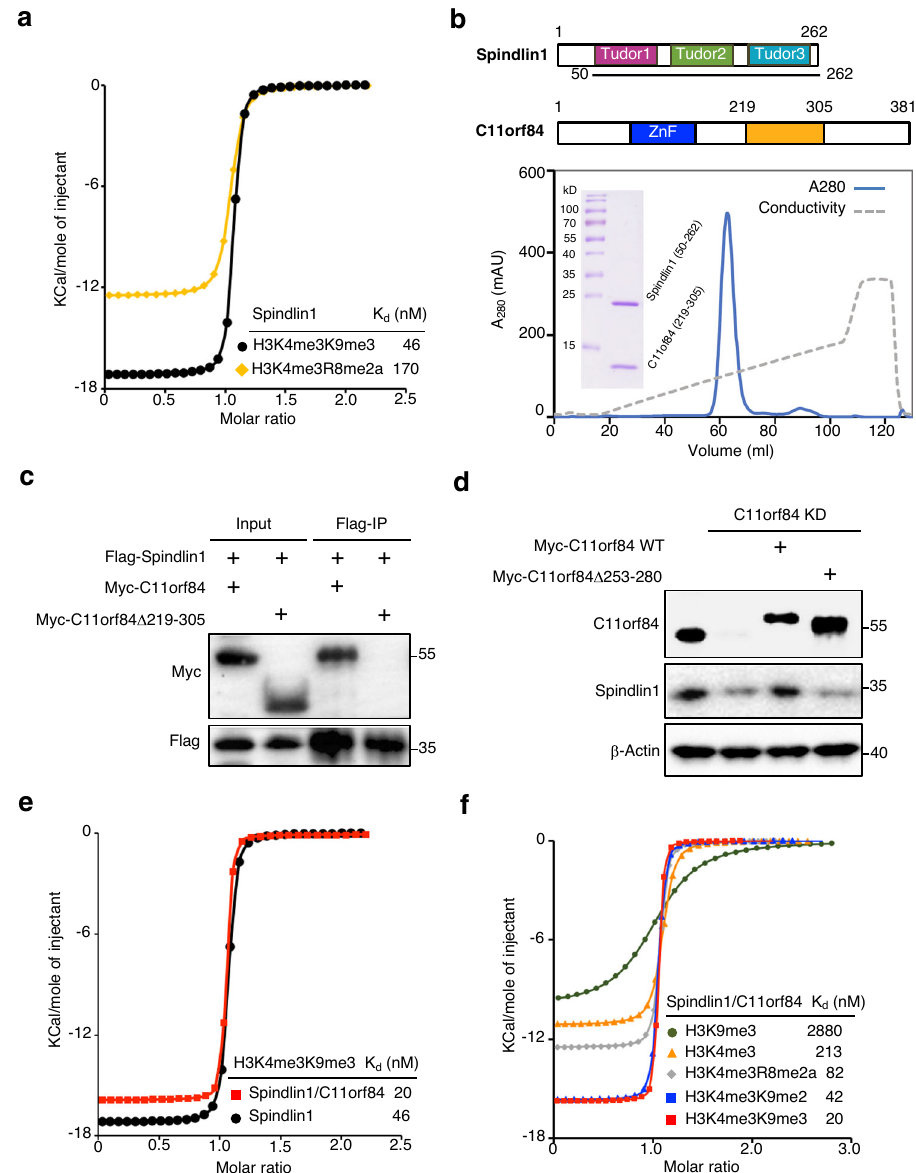
Fig. 1 Spindlin1/C11orf84 complex prefers to recognize non-canonical bivalent mark H3K4me3K9me3. a Quantitative ITC measurements suggest that Spindlin1 binds H3K4me3K9me3 dual mark with a fourfold increase in binding af fi nity over H3K4me3R8me2a. The insert lists the calculated dissociation constant ( K d ). b The top panel shows protein architecture of Spindlin1 and C11orf84. The lower panel shows that Spindlin1 (aa: 50 – 262) forms a stable complex with C11orf84 (aa: 219 – 305) as analyzed by anion-exchange chromatography and SDS-PAGE gel of the peak fraction. c Coimmunoprecipitation (Co-IP) shows the region (aa: 219 – 305) of C11orf84 is responsible for Spindlin1 binding. d Immunoblotting shows the Spindlin1 protein level is dramatically reduced in C11orf84 stable knockdown (C11orf84 KD) U2OS cells, and ectopic expression of wild-type C11orf84 but not the C11orf84 Δ 253-280 mutant restored the Spindlin1 protein level. e ITC measurement shows the Spindlin1/C11orf84 heterodimer binds twofold stronger to H3K4me3K9me3 peptide than Spindlin1 alone. f ITC fi tting curves for binding of Spindlin1/C11orf84 complex to various H3 peptides with dissociation constant ( K d ) values indicated. The thermodynamic parameters are listed in Supplementary Table 1. Source data are provided as a Source Data fi le. structures 15,16 . Trimethylated K4 is inserted into the aromatic Spindlin1 structure as the N-terminal A204-D211 region including an α helix of Tudor 3 domain is well-de fi ned but was invisible in pocket formed by F141, W151, Y170, and Y177 of Tudor 2 the previous determined Spindlin1 structures 15,16 . domain whereas trimethylated K9 is recognized by an aromatic The H3K4me3K9me3 peptide fi ts snugly on the surface of cage formed by residues W62, W72, Y91 and Y98 of Tudor 1, Tudor 1 and 2 of Spindlin1 (Fig. 2d and Supplementary Fig. 3a, and F251 of Tudor 3 domain (Supplementary Fig. 3c, d). In b). Simultaneous recognition of K4me3 and K9me3 appears to be addition to cation- π and methyl- π interactions induced by facilitated by the distance adjustment through the short α -helix dual methylated lysine recognition, the N-terminal amino formation of the H3 fragments consisting of residues 4 – 7. This is group of H3A1 forms a hydrogen bond with the side-chain distinct from the extended conformation of H3 peptide ob- carboxylate group of D189, while the guanidino moiety of H3R2 served in Spindlin1/H3K4me3 and Spindlin1/H3K4me3R8me2a is ion-paired with the side-chain carboxylate group of D184. NATURE COMMUNICATIONS| (2021) 12:949